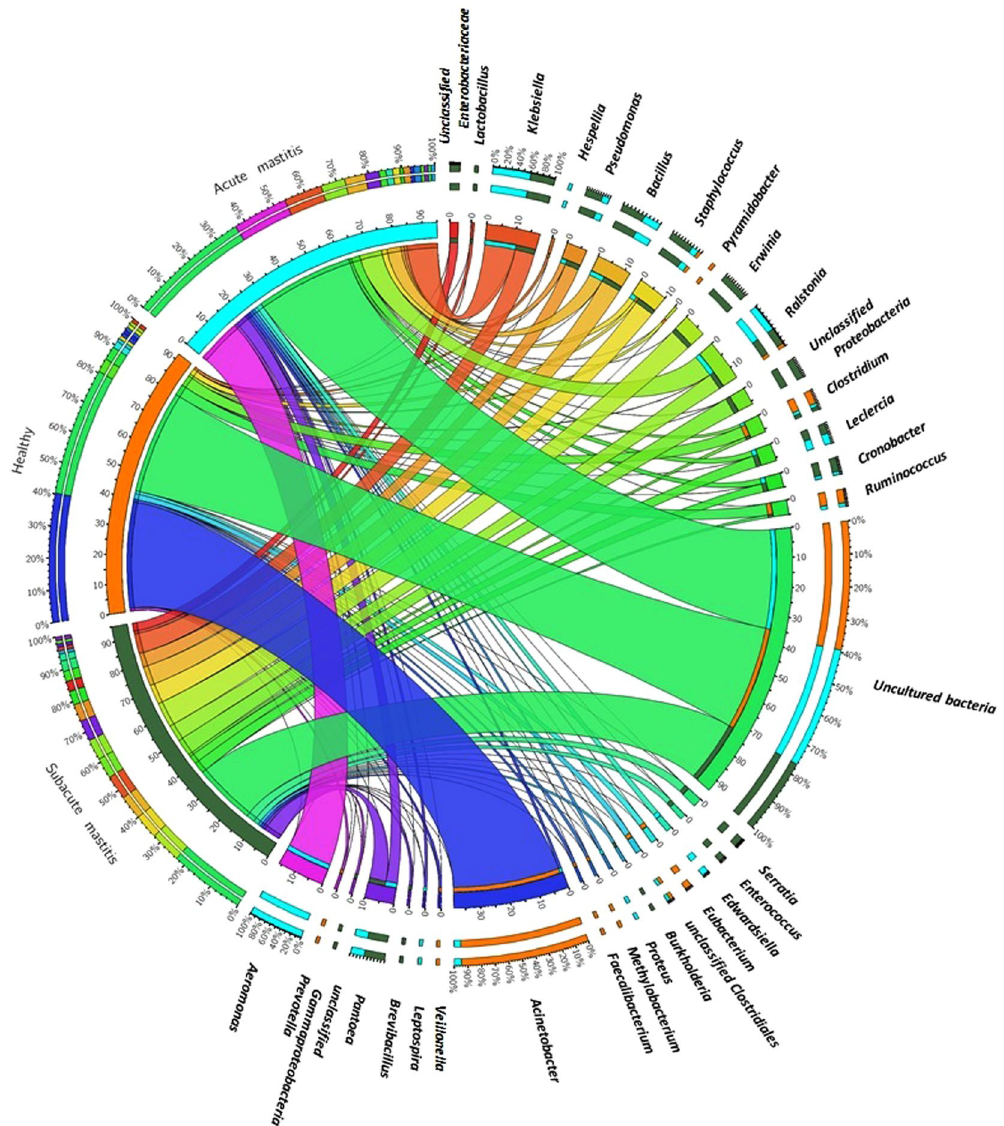
Figure 2. Circos representation of top most abundant bacterial genera between healthy-controls, SAM and AM samples. Bacterial genera having abundance above 0.2% of all bacterial sequences were